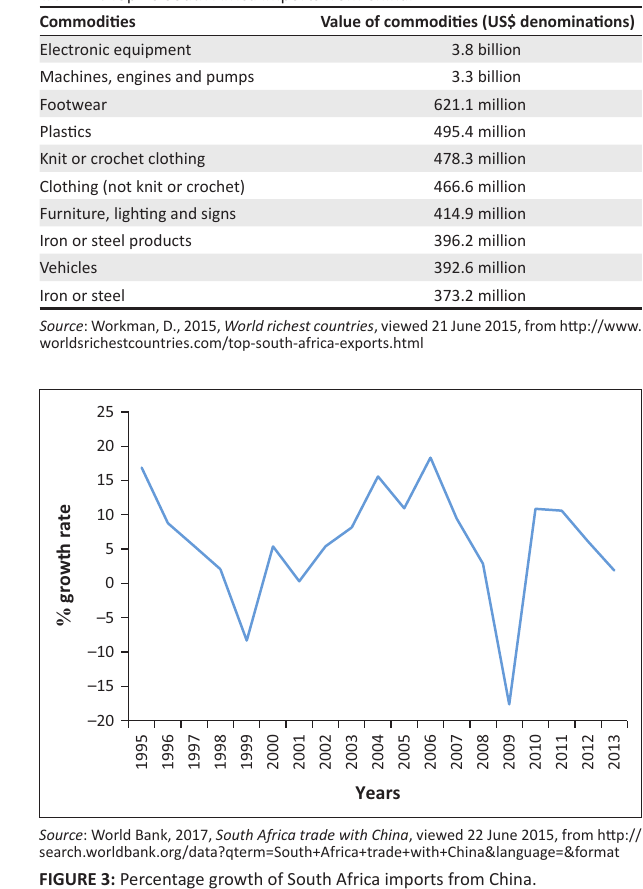
TABLE 2: Top 10 South Africa imports from China.